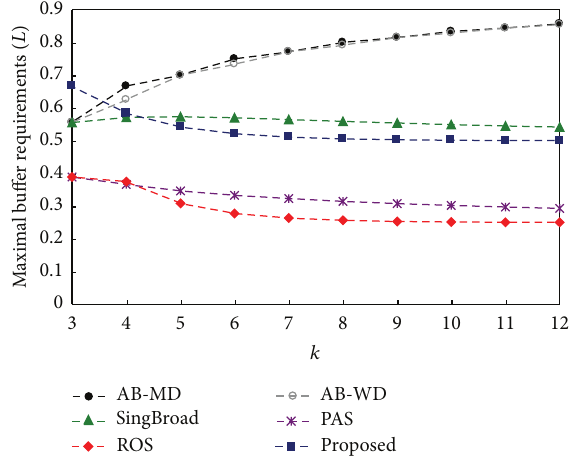
Figure 6: Maximum buffer requirements for AB-MD, AB-WD, SingBroad, PAS, ROS, and the proposed scheme.